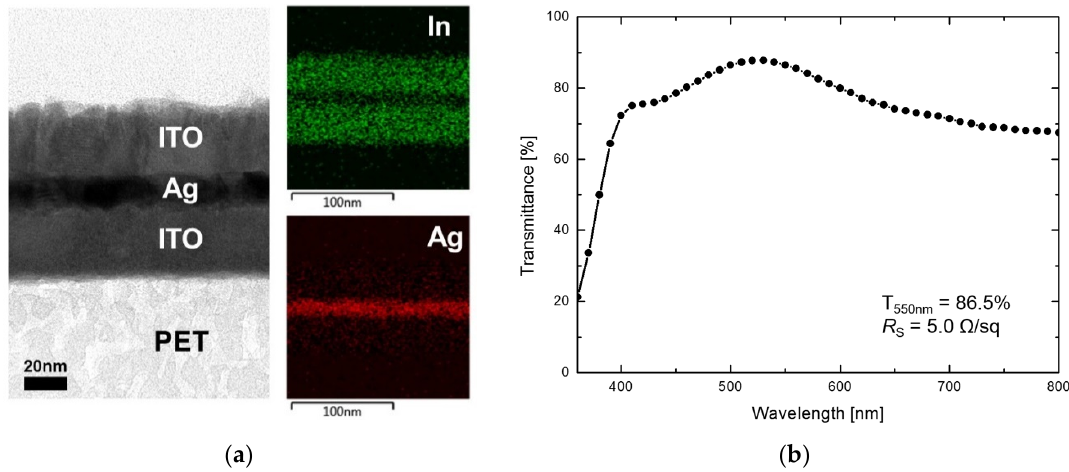
Figure 1. ( a ) Cross-sectional transmission electron microscopy (TEM) and energy-dispersive X-ray spectroscopy (EDS) images of the ITO / Ag / ITO multilayer transparent heater, and its ( b ) optical transmittance spectrum and sheet resistance.